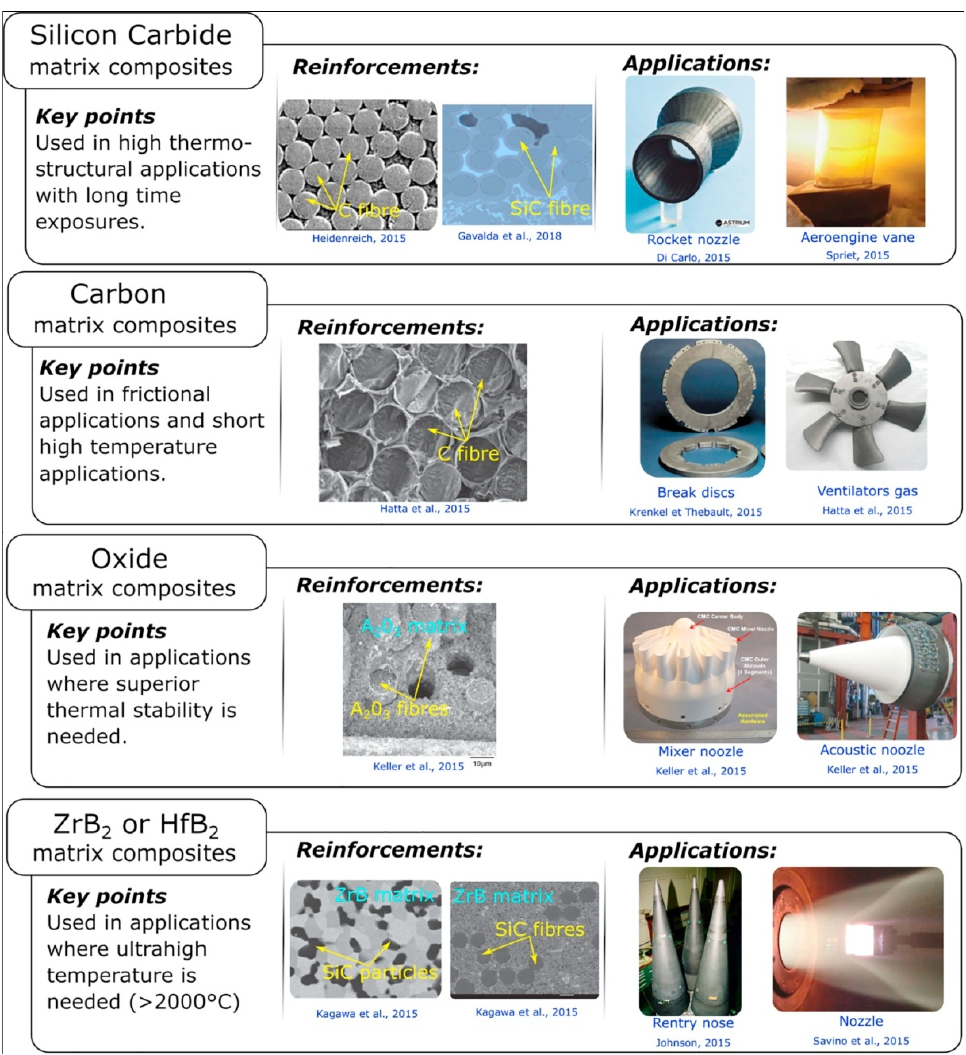
Figure 8. Types of CMC-based applications [108].